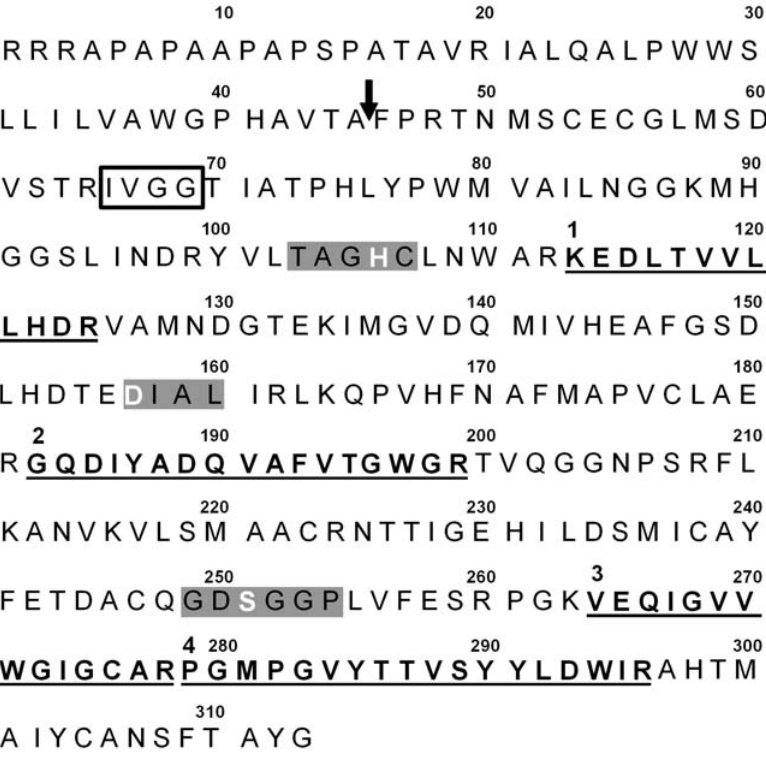
Figure 3. Amino acid sequence of protein ‘‘X’’. The features of the protein ‘‘X’’ sequence include a predicted signal peptide (the sequence 5 9 of the arrow) and cleavage site (at the arrow), a trypsin-like N-terminal motif (open box around IVGG), the three catalytic residues (white letters) in the three conserved motifs (gray boxes) of a serine protease, and the four peptides recovered from MS/MS analysis (labeled 1–4 and highlighted in bold and underlined).